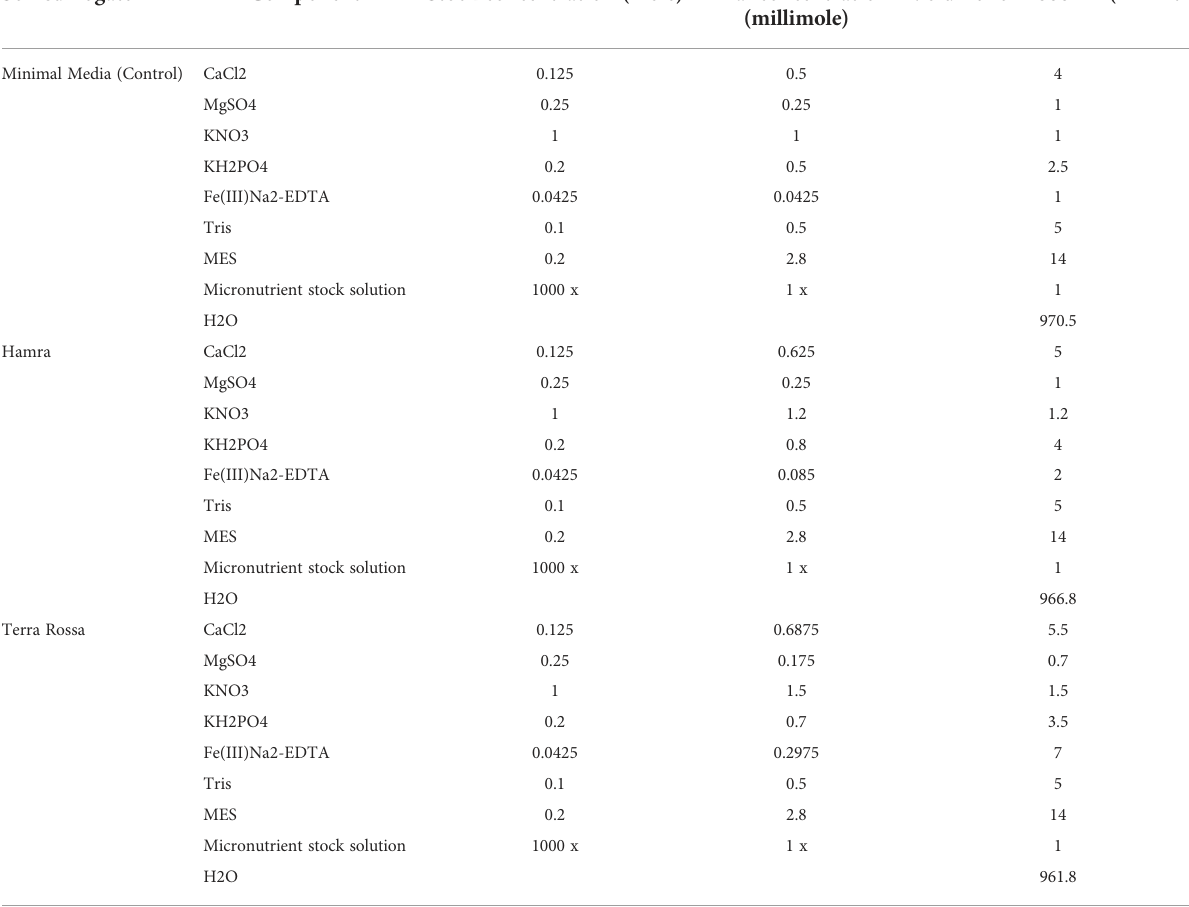
TABLE 2 Composition of soil surrogate root growth media to mimic Hamra and Terra Rossa soils and a control. Soil